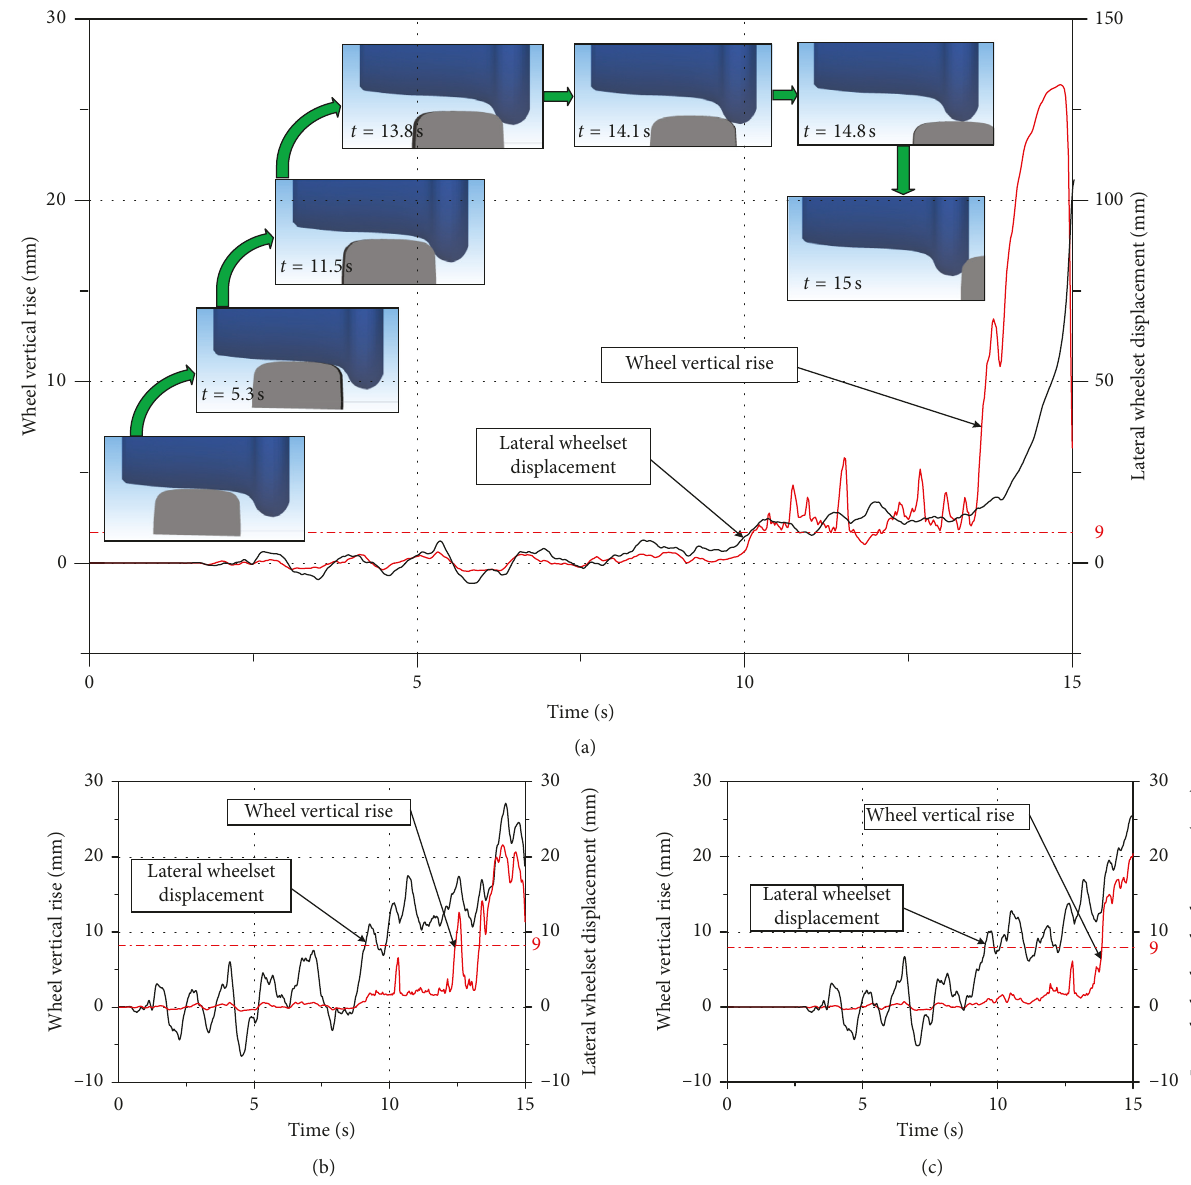
Figure 15: Wheel vertical rise and lateral wheelset displacement of different wagons: (a) middle wagon; (b) front wagon; (c) rear